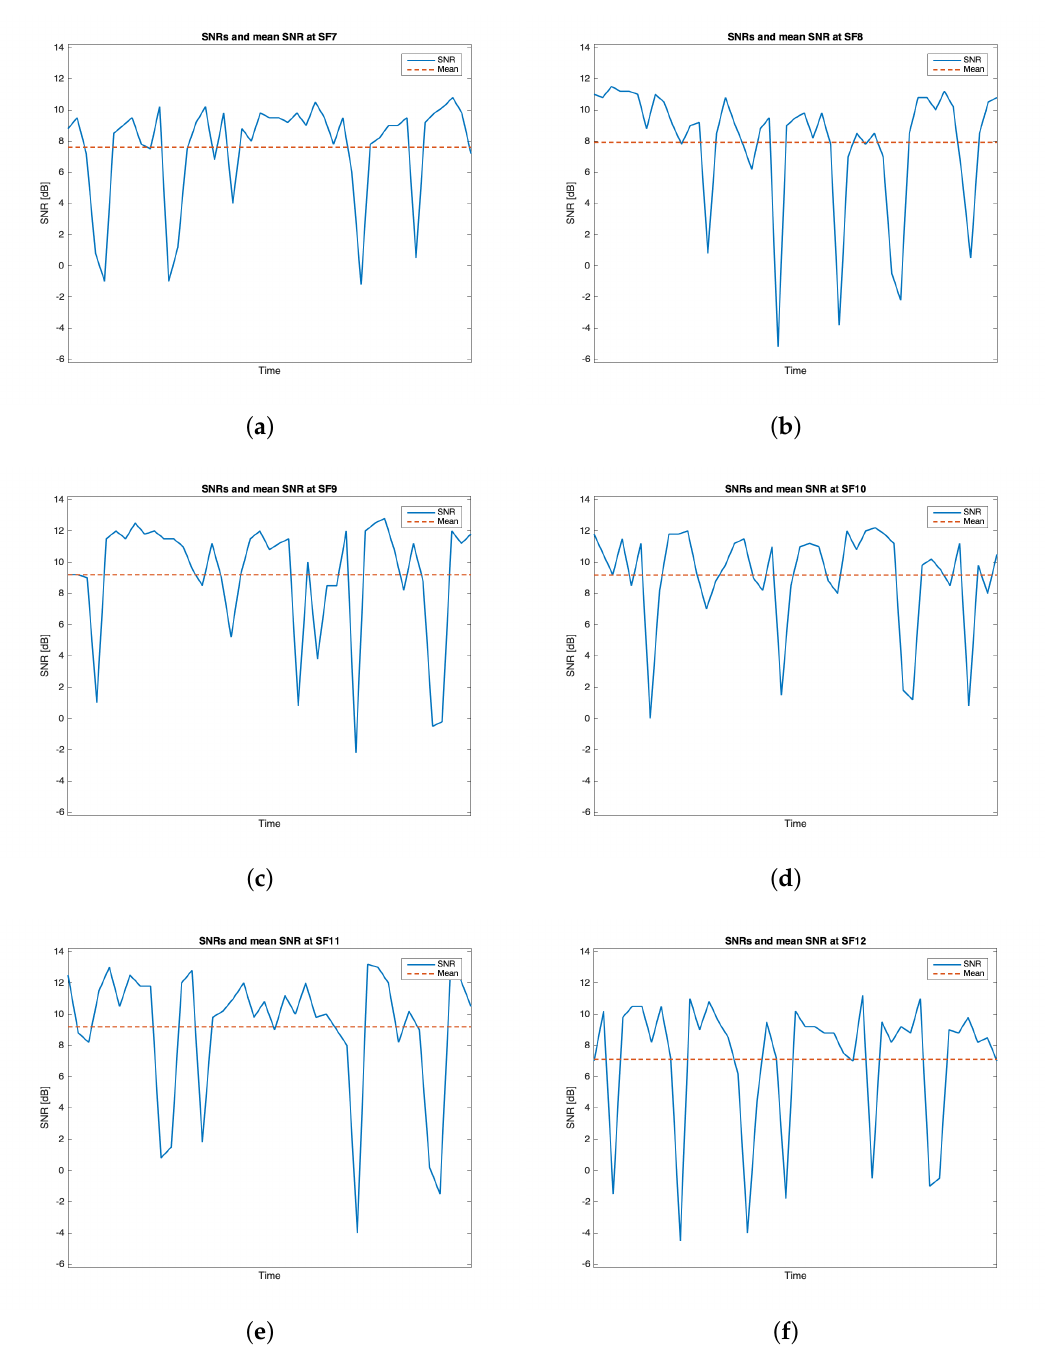
Figure 13. Group #1 SNRs temporal trend: ( a ) SF = 7; ( b ) SF = 8; ( c ) SF = 9; ( d ) SF = 10; ( e ) SF = 11; ( f ) SF =